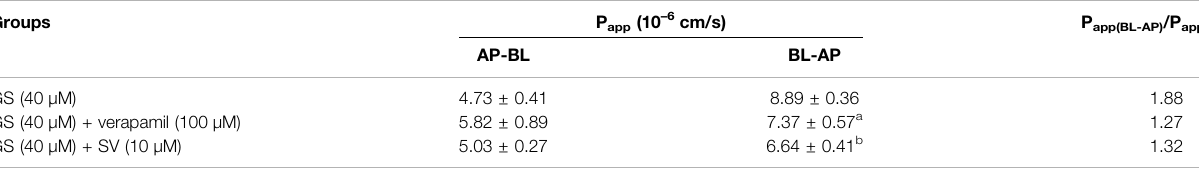
TABLE 3 | Effects of verapamil (100 µM) and SV (10 µM) on the transport of GS (40 µM) in the MDCKII-MDR1 monolayer cell model ( n (cid:1) 3). Groups